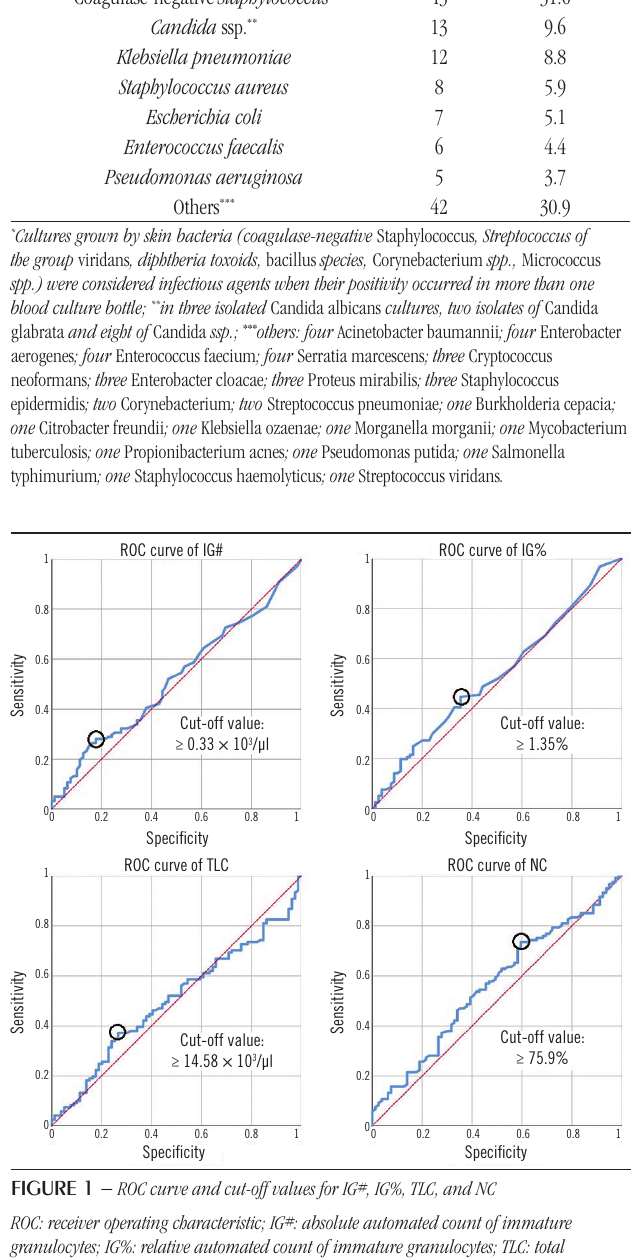
taBLE 3 − Microorganisms isolated from cultures of biological specimens Microorganisms isolated